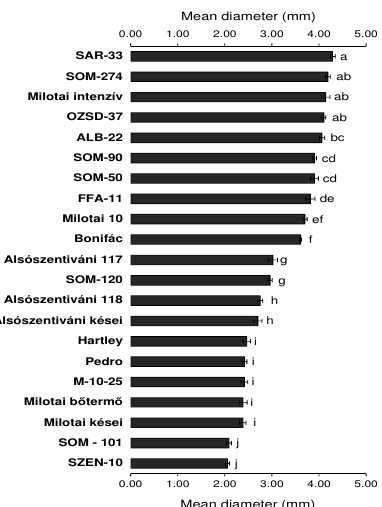
Fig. 2. Mean diameter of spots produced by two Xaj isolates around the inoculation (2010-2013) Values with the different letter indicate cultivars that differ significantly (Duncan’s test, p≤0.05); The error bars show SE of the mean